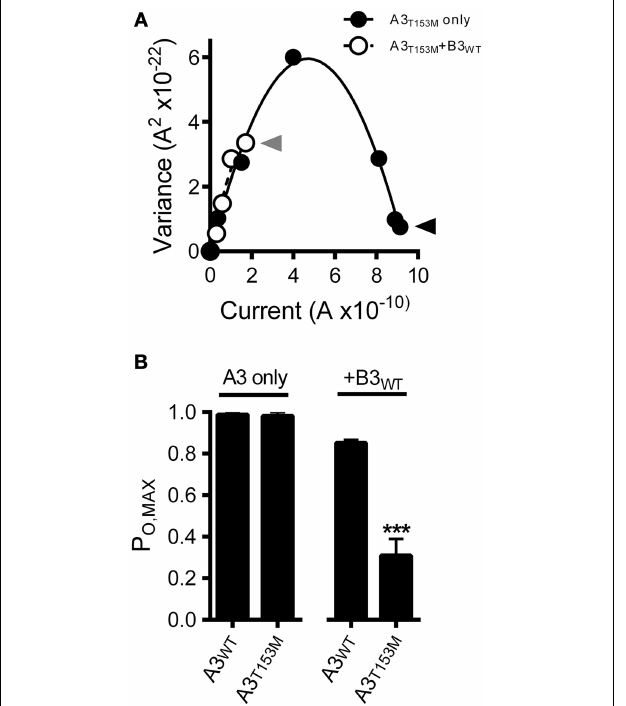
FIGURE 5 | CNGA3-T153M polymorphism decreases the maximum open probability for heteromeric but not homomeric CNG channels. (A) Current-variance plot for A3 T153M homomeric (open circles) and A3 T153M + B3 (closed circles) channels following activation by various concentrations cGMP at + 80mV (as in Figure 3 ). Continuous lines were produced by fitting with a 2nd-order polynomial using the following best-fit parameters: A3 T153M (solid), i = 2 . 5 pA, N = 370 channels; A3 T153M + B3 (hashed), i = 2 . 5 pA, N = 370 channels. Arrows denote mean variance at saturating cGMP for A3 T153M (solid) and A3 T153M + B3 (hashed). (B) Maximum open probability was decreased for heteromeric A3 T153M + B3, but not homomeric A3 T153M channels compared to wild-type channels ( *** p < 0 . 001 , Student’s t -test, n = 4 –8).